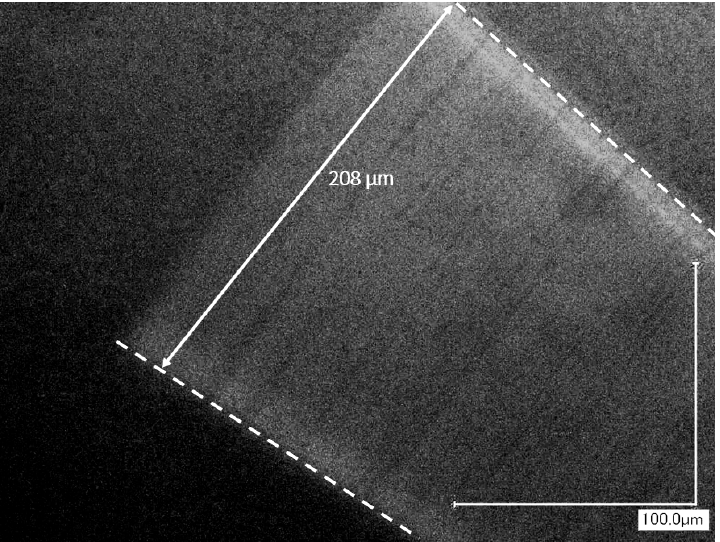
Figure 14. Tip displacement of the 2411-Hz brass sample at 0.461 W (with an 8° compensation due to viewing angle).